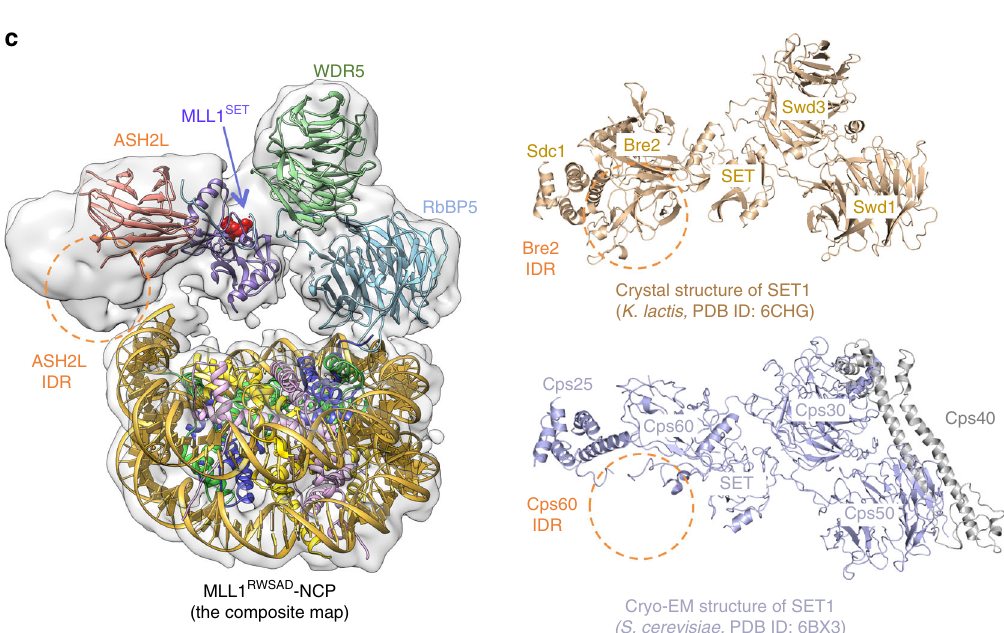
Fig. 3 The WDR5-MLL1 SET -ASH2L SPRY -NCP subcomplex. a Rigid-body fi tting of human WDR5 crystal structure (PDB ID: 2H14) 28 into the cryo-EM map of MLL1 RWS -NCP. Secondary structures of WDR5 were shown in green. b Rigid-body fi tting of MLL1 SET and ASH2L SPRY into the Cryo-EM map of MLL1 RWSAD - NCP. The MLL1 SET -RbBP5 330 – 375 -ASH2L SPRY crystal structure (PDB ID: 5F6L) 16 was used. Characteristic secondary structures of MLL1 SET (SET-I, SET-C and SET-N) were shown within black dashed circles. The catalytic active site represented by red sphere. c , Comparison of human MLL1-NCP structure with yeast SET1 crystal structure ( K. lactis , dark goldenrod, PDB ID: 6CHG, right top) 20 and cryo-EM structure ( S. cerevisiae , light slate blue, PDB ID: 6BX3, right bottom) 21 . Orange circles indicated IDR regions of ASH2L (human), Bre2 ( K. lactis ), and Cps60 ( S. cerevisiae ). An extra domain in S. cerevisiae SET1 complex, Cps40, colored